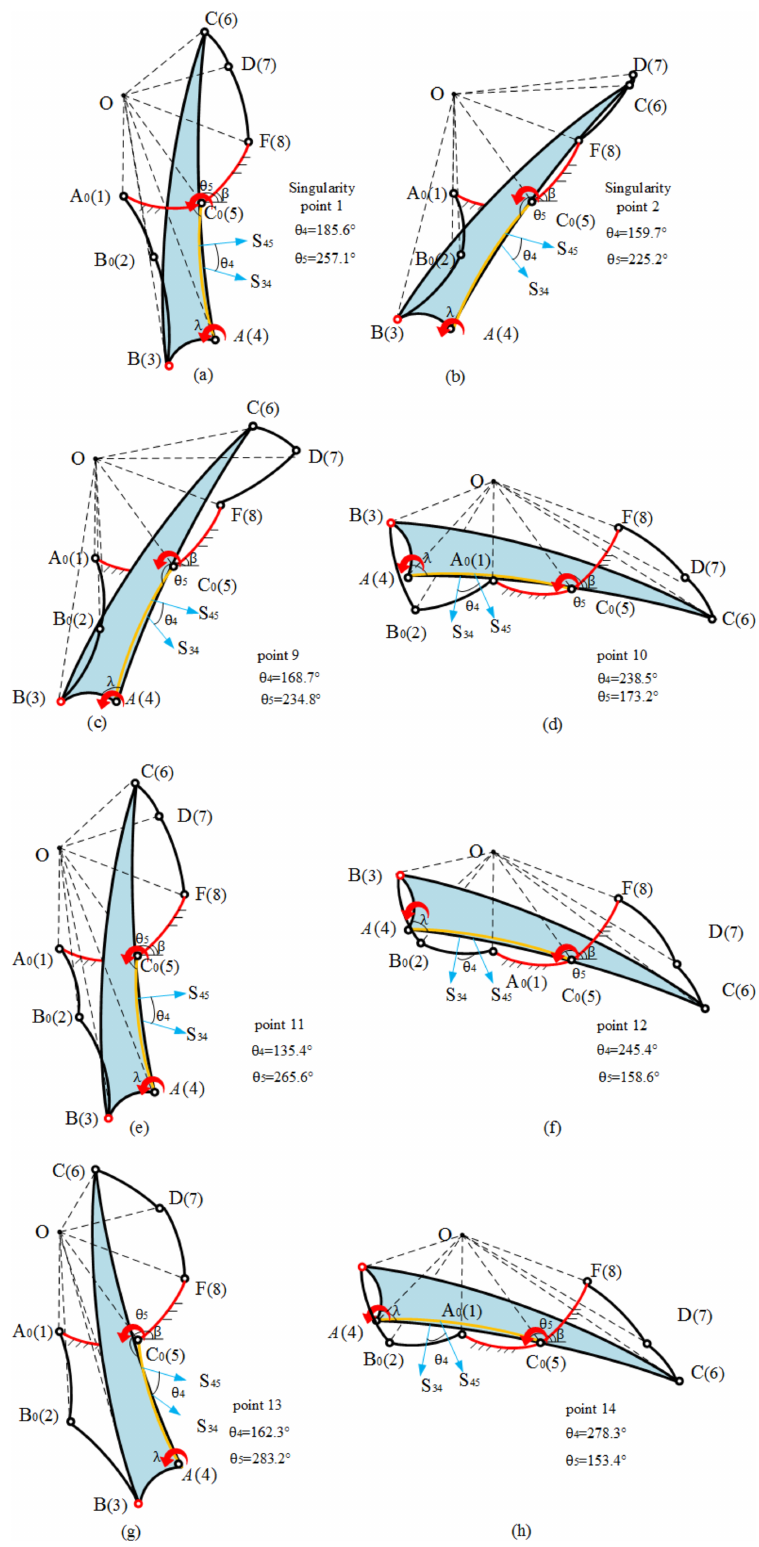
Figure 5. Several configurations of the SPM. (a, b) Singularity points 1 and 2 belong to the case (cid:49) 1 = 0 and (cid:49) 2 = 0. (c, d) Points 9 and 10 belong to the case (cid:49) 1 = 0 and (cid:49) 2 > 0. (e, f) Points 11 and 12 belong to the case (cid:49) 1 > 0 and (cid:49) 2 = 0. (g, h) Points 13 and 14 belong to the case (cid:49) 1 > 0 and (cid:49) 2 >